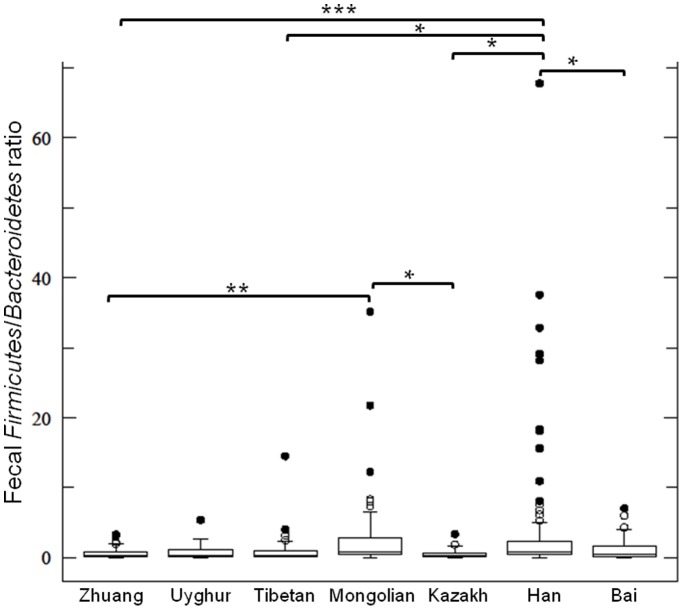
Box-plots of the Firmicutes/Bacteroidetes ratio of the 7 ethnic groups.Boxes show the median, 25th and 75th percentiles. The lower and upper adjacent hinges are 1.5× interquartile range (IQR) from the 1st and 3rd quartiles, respectively. ‘Suspected upper outliers’ >1.5 and >3 times of the IQR above the 3rd quartile are symbolized with open and filled circles, respectively. No lower outlier was detected in any of the groups. The significant difference between sample pair was evaluated by pairwise Mann-Whitney test with Bonferroni correction. A corrected p-value <0.05 and 0.01 are denoted by ‘*’ and ‘**’, respectively. The obtained p-values are given in Table S5.